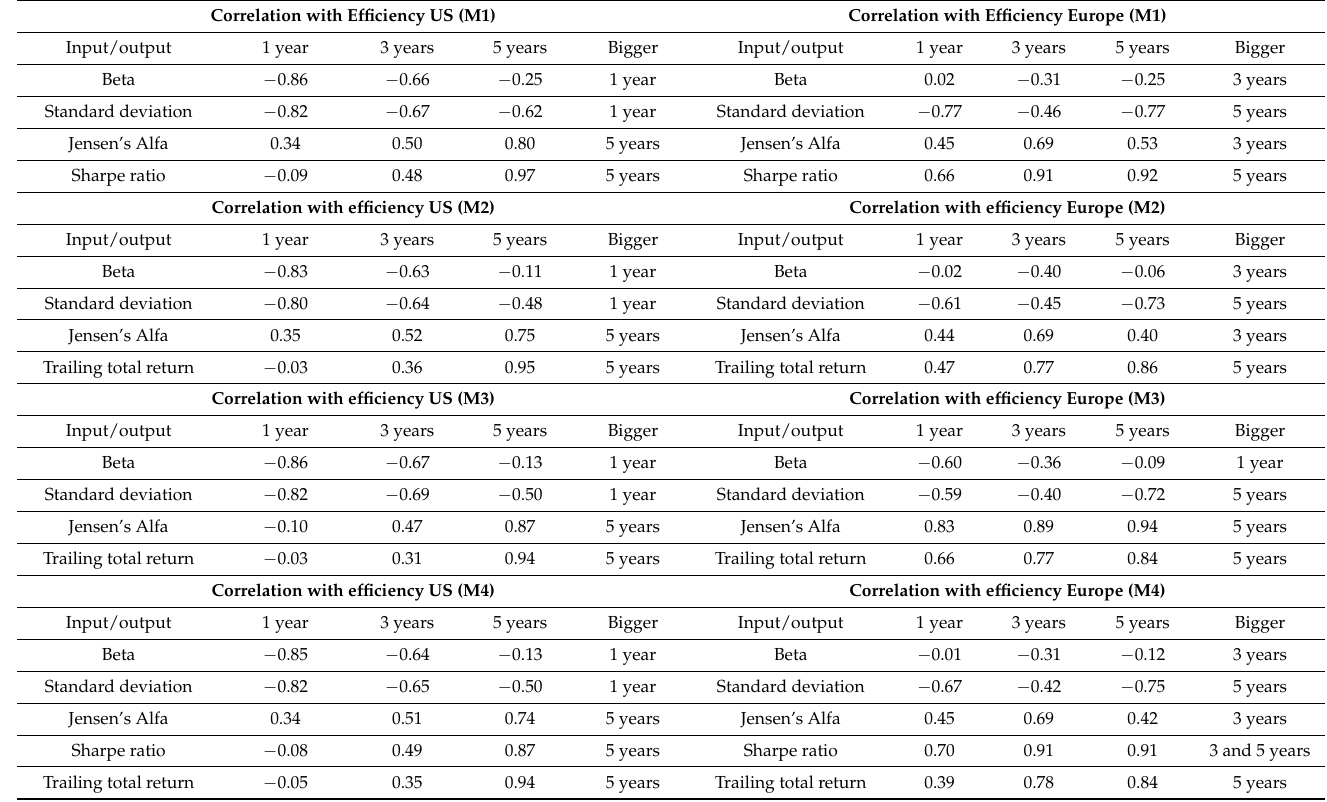
Table A15. Correlation of the efficiency scores with inputs and outputs for each model by region (US and